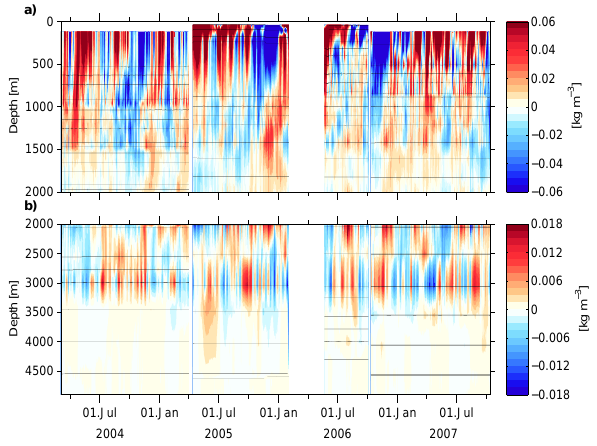
Fig. 5. 2-day low-pass filtered in-situ density anomaly at EBH, (a) from 0 to 2000m and (b) from 2000m to the bottom. Dates go from 4 March 2004 to 14 October 2007. For clarity, the anomalies computed around the time mean for each deployment period are shown. Note that panels (a) and (b) have different color scales. Horizontal lines are the levels of the measurements.